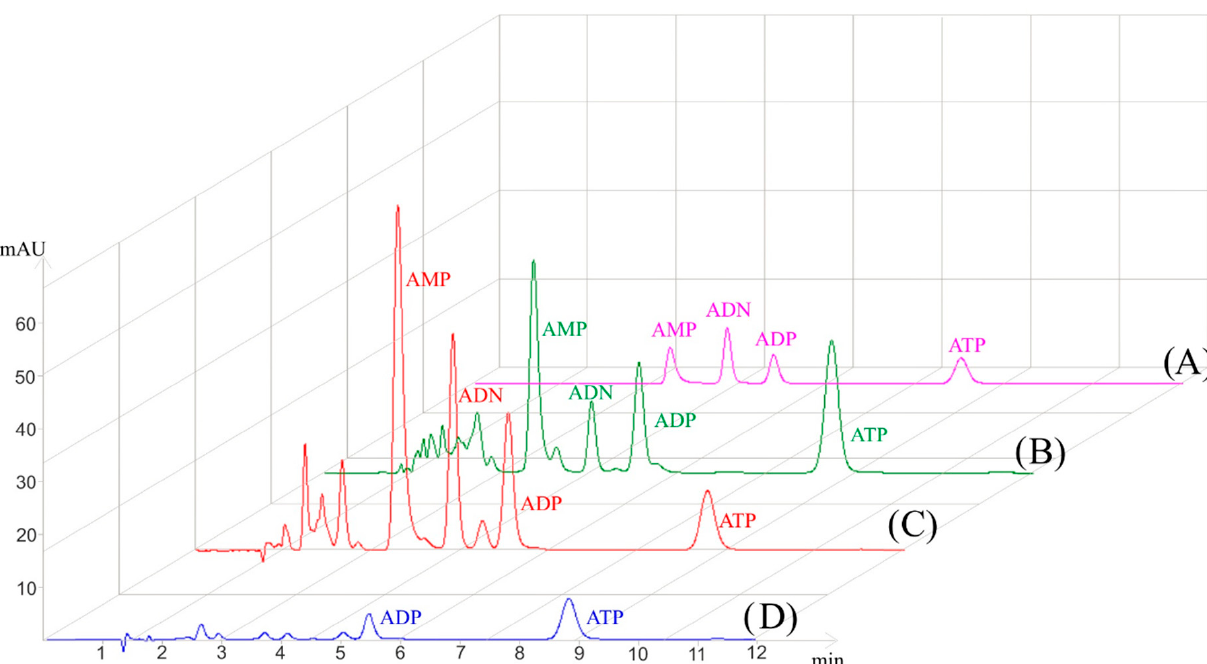
Figure 3. HPLC chromatograms of adenylate standards ( A ) and adenylates extracted from G. fossarum samples (B–D). ( A ) standards AMP, ADN, ADP, and ATP in the concentration of 25 μ M; ( B ) G. fossarum homogenate with pH around 11; ( C ) fraction 1 of G. fossarum sample enriched on AssayMap Bravo platform; ( D ) fraction 2 of G. fossarum sample enriched on AssayMap where no AMP and ADN were eluted. For chromatographic separation conditions see Section 2.4.